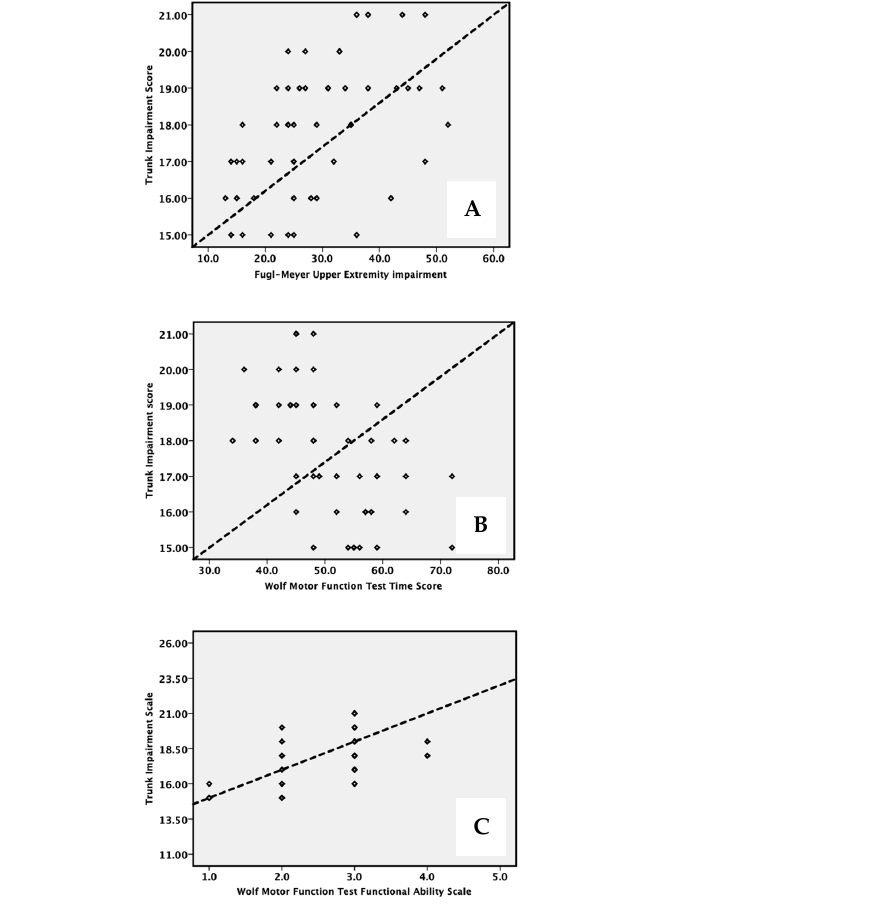
Figure 2. Correlation between trunk control (TIS) and ( A ) FMA ‐ upper extremity, ( B ) WMFT ‐ Time score and score, and ( C ) WMFT ‐ Functional ability scale. Dashed line = regression line. TIS exhibited moderate positive correlations with FMA ‐ UE (r = 0.52), WMFT ‐ time scale (TS) (r = − 0.55), and WMFT ‐ functional ability scale (FAS) (r = 0.50). In all cases, the p ‐ value is less than 0.001